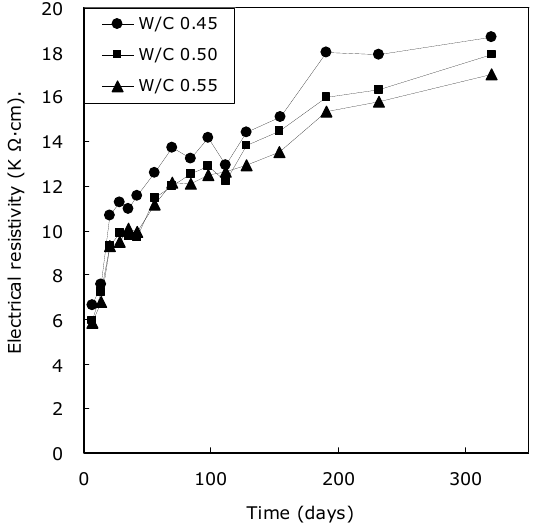
Figure 4. Electrical resistivity measurements of the saturated concrete without chloride.